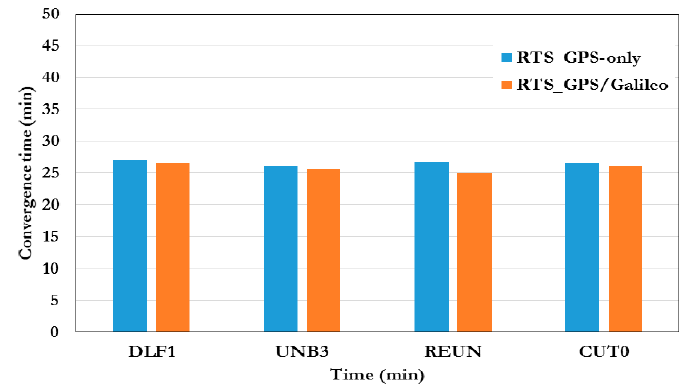
Figure 8. A summary of the convergence time of RT-PPP solutions using IGS03 satellite clock correction. Figure 9 shows the standard deviations of the station coordinates in the East, North, and Up directions, respectively. As can be seen, the use of IGS03 satellite corrections improves the RT-PPP solution precision, in comparison with other real-time satellite correction